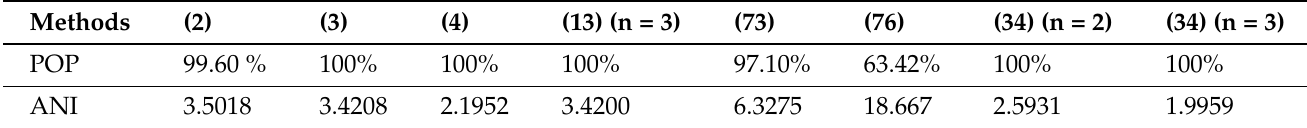
Table 3. Numerical results of different methods for z 4 − 1 =